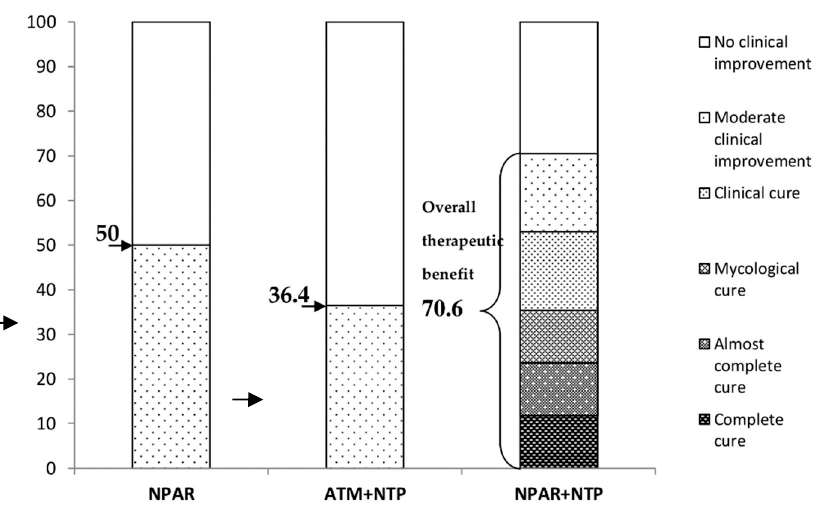
Figure 9. Therapeutic e ff ect (%) in particular groups of patients.